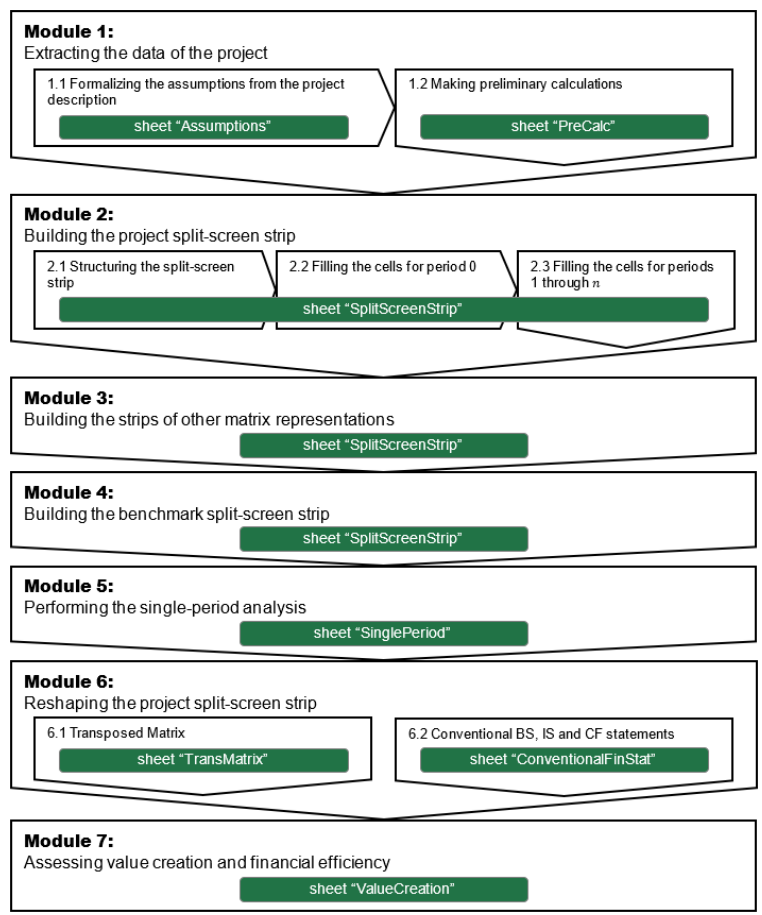
Figure 1. Structure of the paper and of the spreadsheet file.